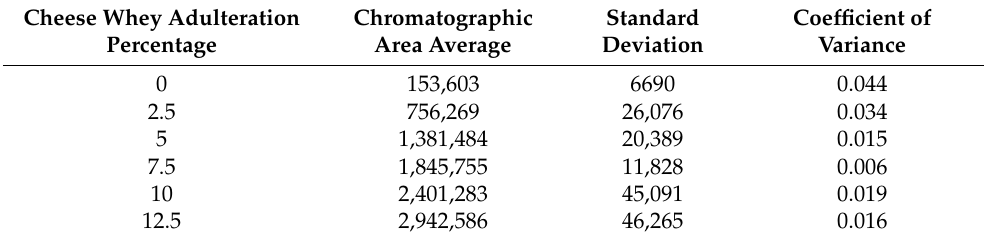
Table 1. Data were obtained for the signal of interest chromatographic area, according to cheese whey adulteration percentage. High accuracy was achieved by this method, according to the results’ standard deviations and coefficient of